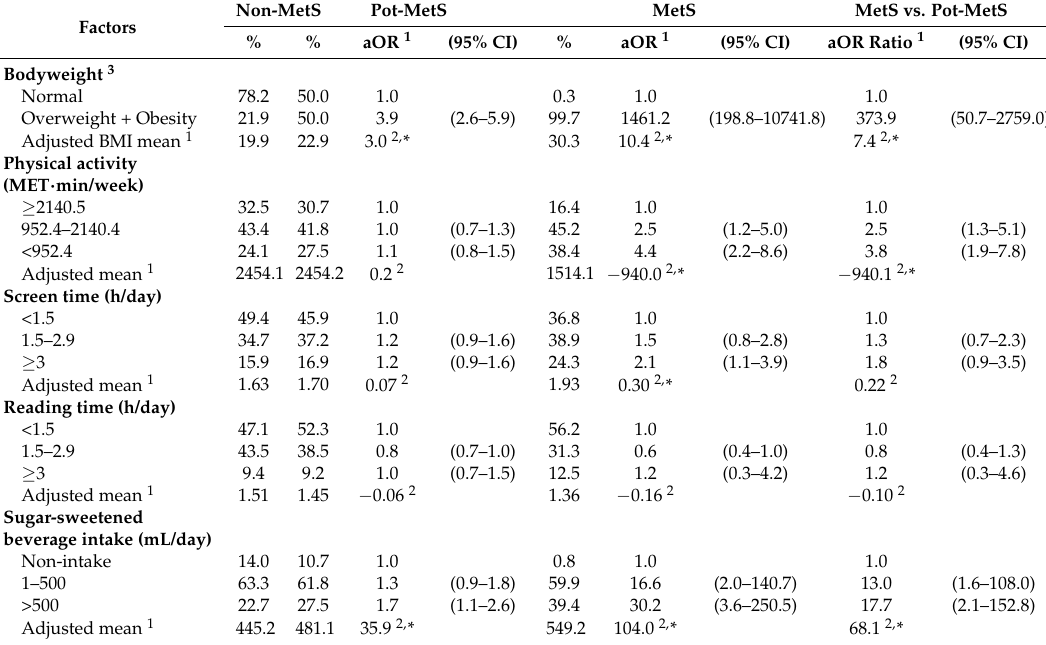
Table 3. Adjusted odds ratios and means of adolescent potential metabolic syndrome and metabolic syndrome associated with adolescent bodyweight and lifestyle factors.